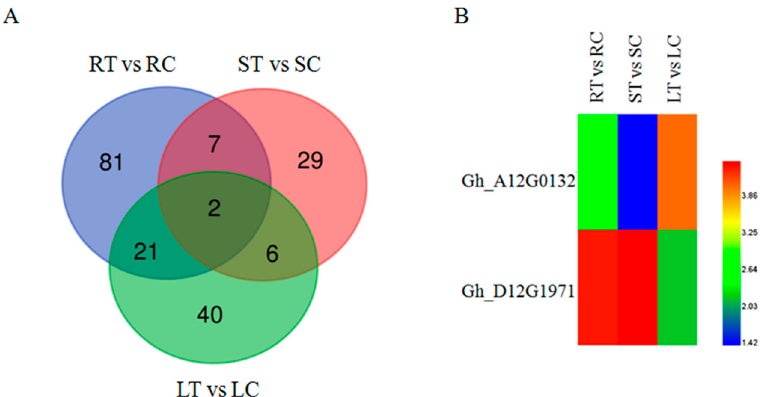
Figure 6. ( A ) Venn diagrams of DEGs in the GO term (GO: 0046686) under Cd stress; ( B ) Cluster map of DEGs in the GO term under Cd stress (GO: 0046686). The red color represents the highest expression, the blue color represents the lowest expression. The samples treated with CdCl 2 were called RT, ST and LT. The samples not treated with CdCl 2 were called RC, SC, and LC, respectively. Then ‘R’ indicates the root tissue, ‘S’ indicates the stem tissue, ‘L’ indicates the leaf tissue, ‘T’ indicates the treated, ‘C’ indicates the control.